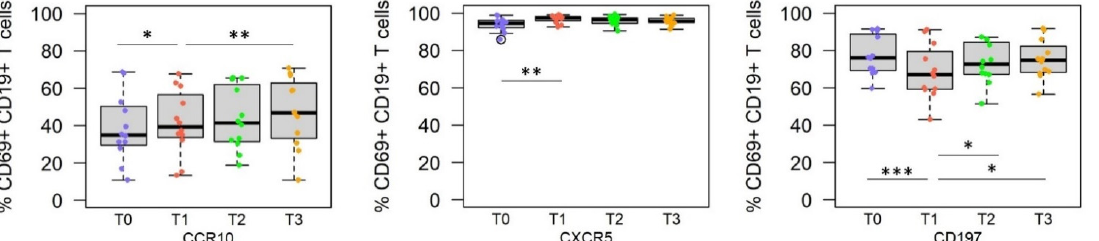
Figure 1. Homing receptor profiles of SPZ-specific B cells at different time points after vaccination and CHMI. Statistical analysis revealed that the frequency of CD69 + B cells expressing the skin- specific marker CCR10 (left panel), B cell compartment-specific CXCR5 (middle panel), and T